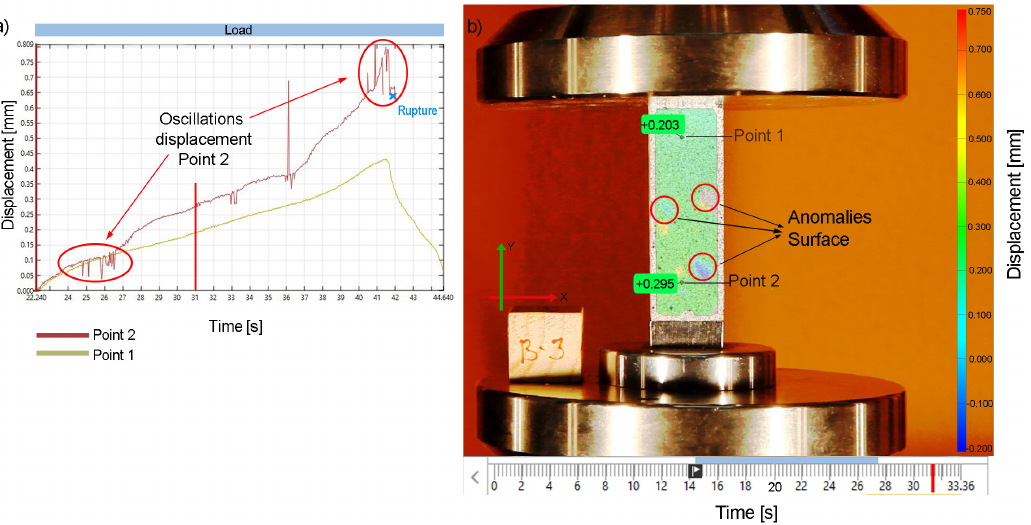
Figure 11. ( a )DisplacementdiagramwithoscillationsofPoint2(P 2 )and( b )anomaliesofthedisplacements on the surface of specimen B3.